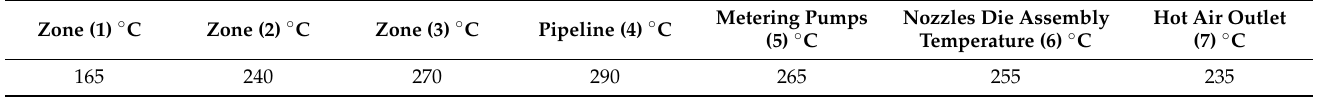
Table 1. Processing